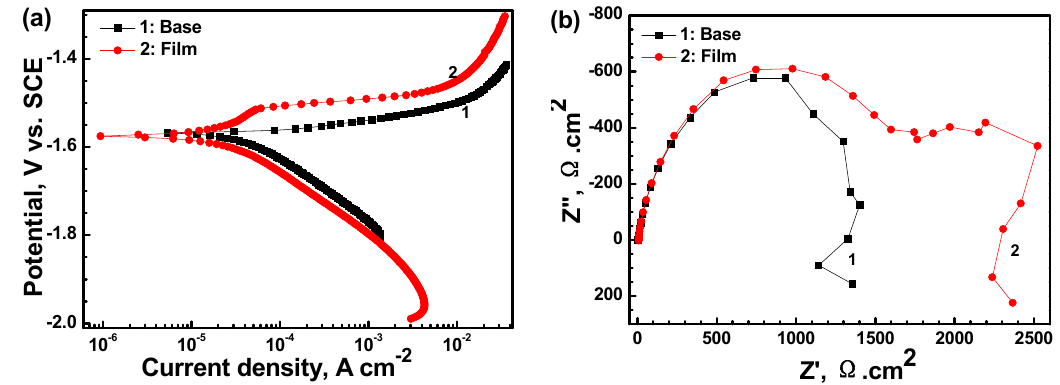
Figure 5. ( a ) Polarization curves and ( b ) Nyquist plots of the AM60 alloy with and without film immersed in 0.6 M NaCl solution.